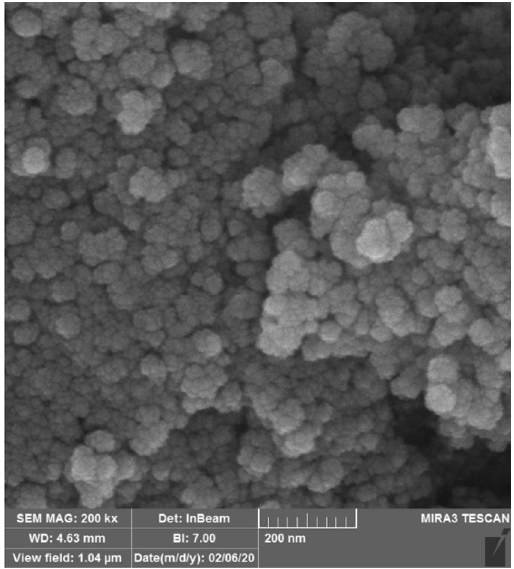
Figure 11. SEM image of Fe 3 O 4 -PTMSNAS@Cu MNPs after recovery.